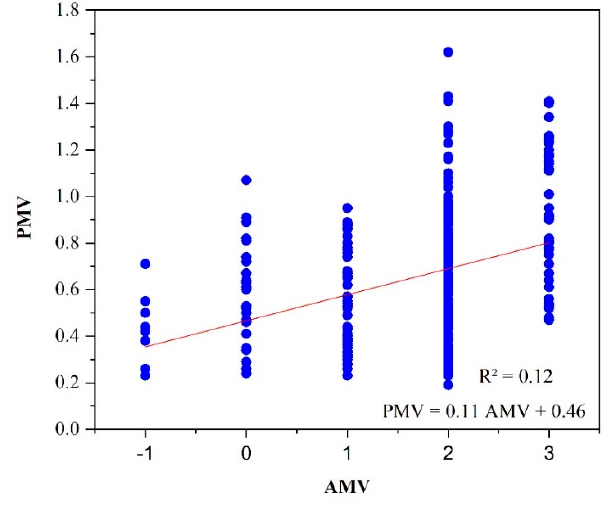
Figure 8. Relationship between predicted mean vote (PMV) and actual mean vote (AMV).